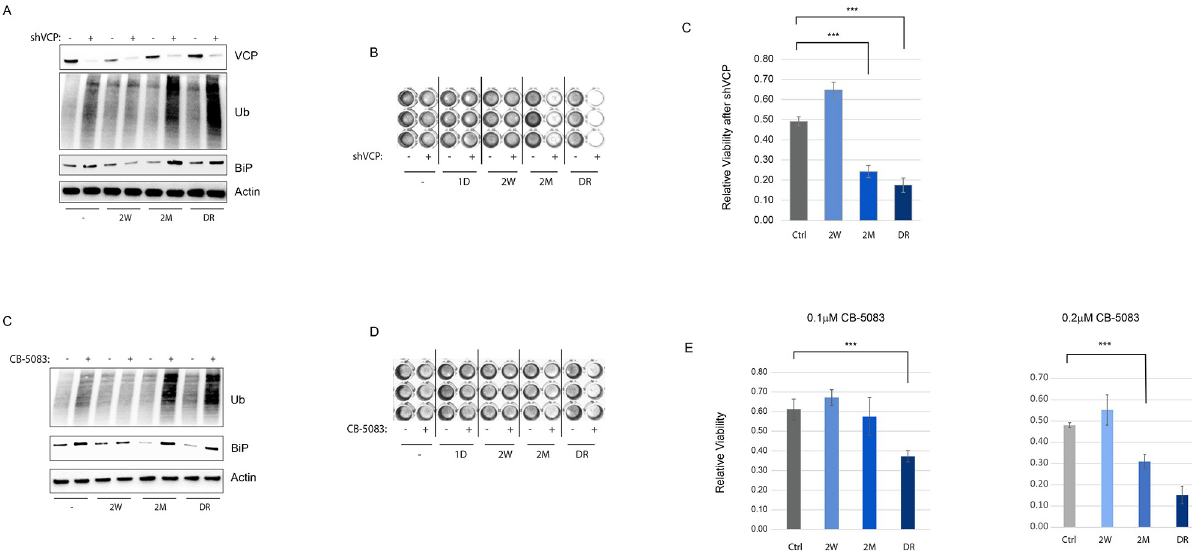
Fig 6. Acquired resistance to lapatinib creates hyper-dependence on ERAD for survival. A) Western of Ub (for poly-ubiquitinated proteins) and BiP (ER stress response marker) after silencing of p97 VCP in the indicated stages of lapatinib treatment. B) Images of Crystal Violet stained wells of 96-well plate after 72hrs of silencing of VCP in cells of the indicated stages of lapatinib exposure. C) Quantitation of the relative intensities of readings in (B). D-E) Similar to A,C but using 0.1 and 0.2 μ M treatment with CB-5083, a highly selective clinical grade inhibitor of VCP. Statistics: error bars show standard deviations from 6 replicate samples. Data are representative of at least 2 independent experiments. ��� : P < 0.01 with student’s t-test.